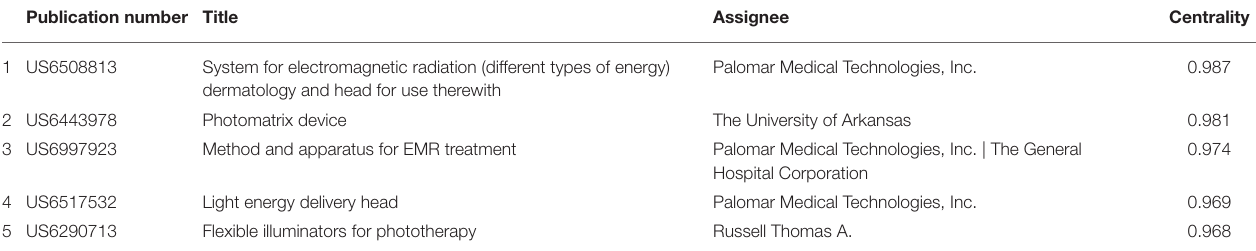
TABLE 11 | Top five central patents for the optical energy-based therapeutic technological domain with their assignees and centrality